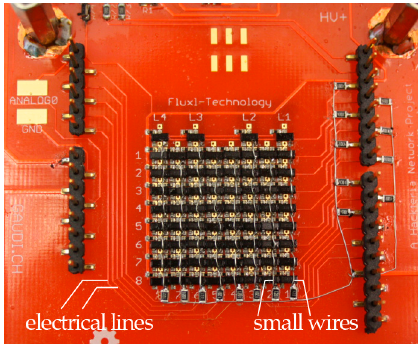
Figure 9. High Voltage Transistors used: BSS131, Infineon SIPMOS, Logic-Level, PG-SOT-23. Each transistor is connected to the corresponding electrode through a small through-hole wire, soldered manually. Electrical lines are transporting the high voltage from the power converter to the electrodes.